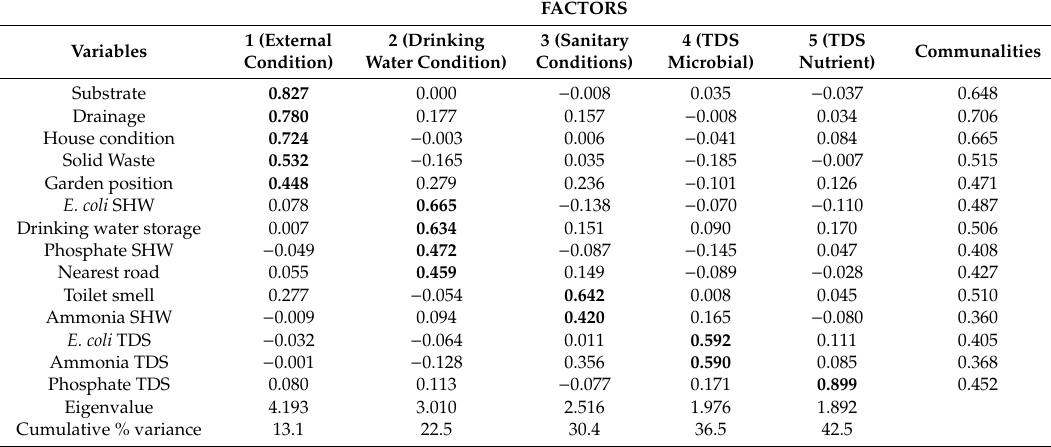
Table 2. Summary of Exploratory Factor Analysis for residential risk of typhoid fever using Maximum Likelihood estimation with Varimax rotation showing communalities, % variance explained and eigenvalues ( n = 497), Fiji typhoid case-control study, 2014–2015. Only significant factors and associated variables are shown. Factor loadings above 0.4 are shown in bold. SHW = source of house water; TDS = toilet drainage